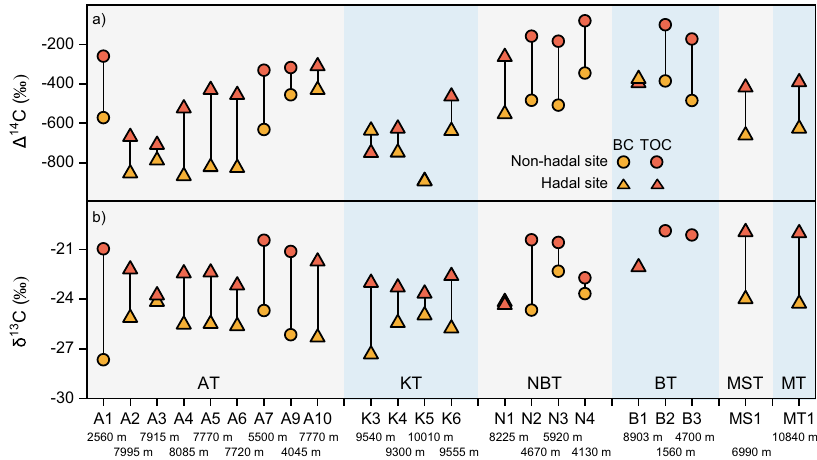
Fig. 4 Offset of carbon isotopic compositions between black carbon (BC) and total organic carbon (TOC) in surface sediments from six trench regions. a radioactive carbon isotopic composition ( Δ 14 C). b stable carbon isotopic composition ( δ 13 C). AT Atacama Trench, BT Bougainville Trench, KT Kermadec Trench, MST Mussau Trench, MT Mariana Trench, NBT New Britain Trench. Note the δ 13 C data of the BC at sites B1, B2 and B3 (BT) are not